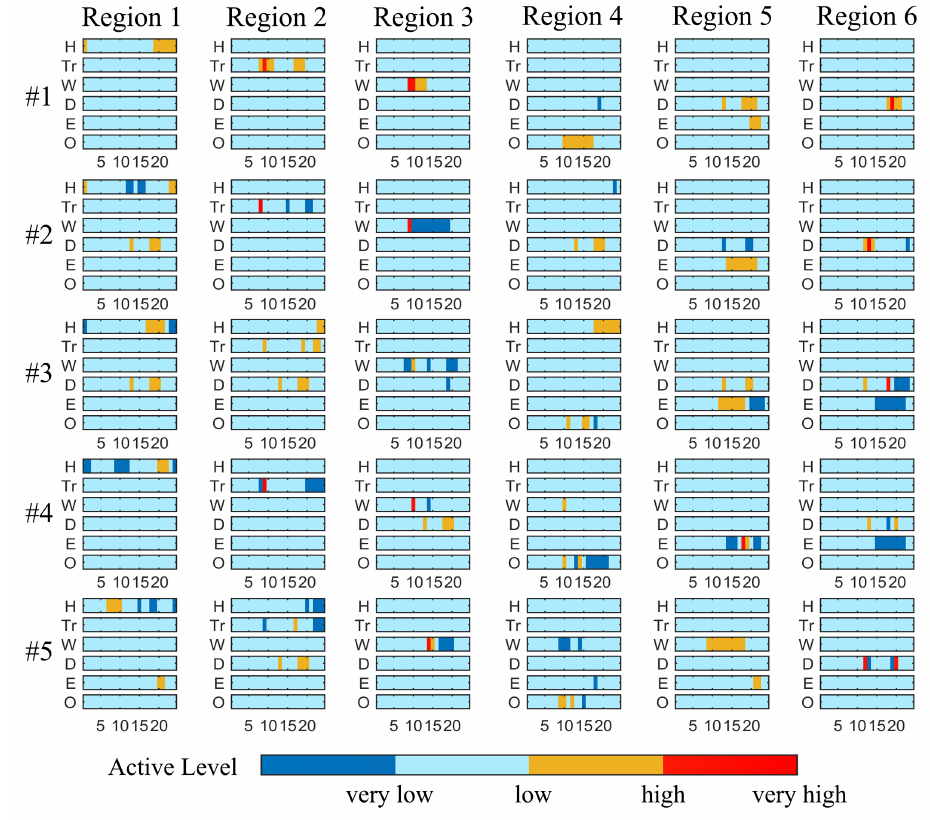
Figure 8. Significant eigenplaces of each region (LRA